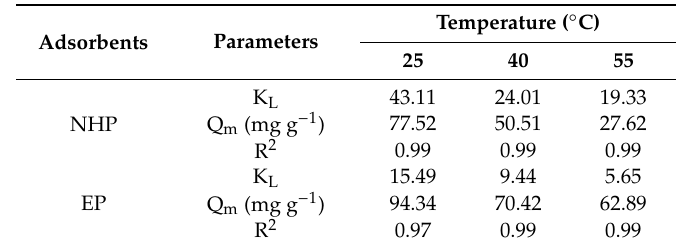
Table 2. Langmuir isotherm parameters for EGCG adsorption onto processed pomelo peel at di ff erent temperatures.